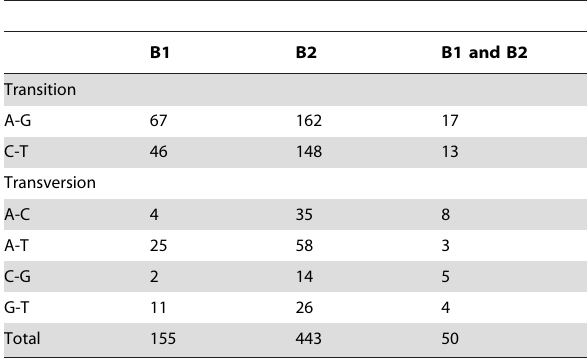
Table 1. Type of putative SNPs identified in soybean aphid A. glycines .